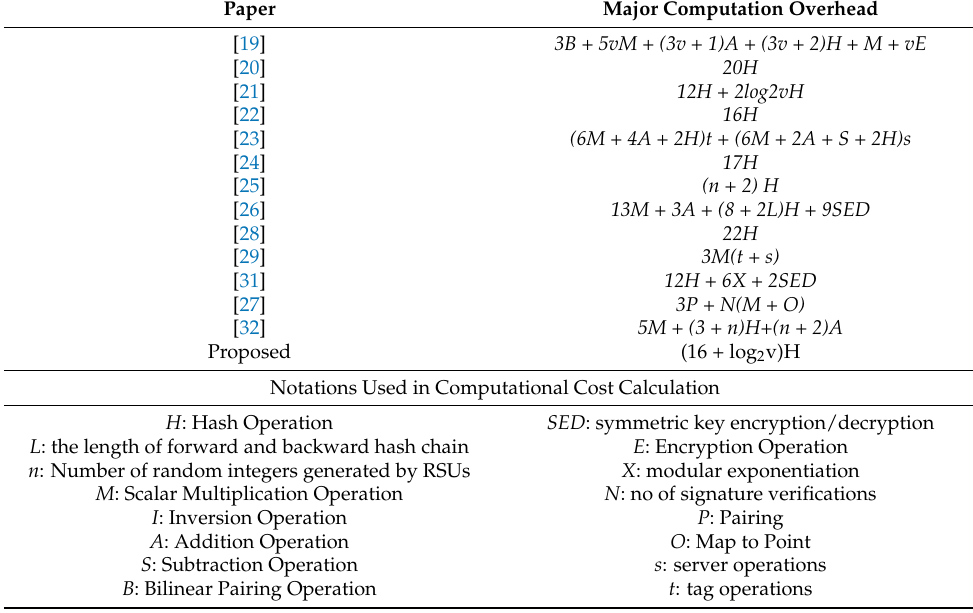
Table 7. Calculation of Computational